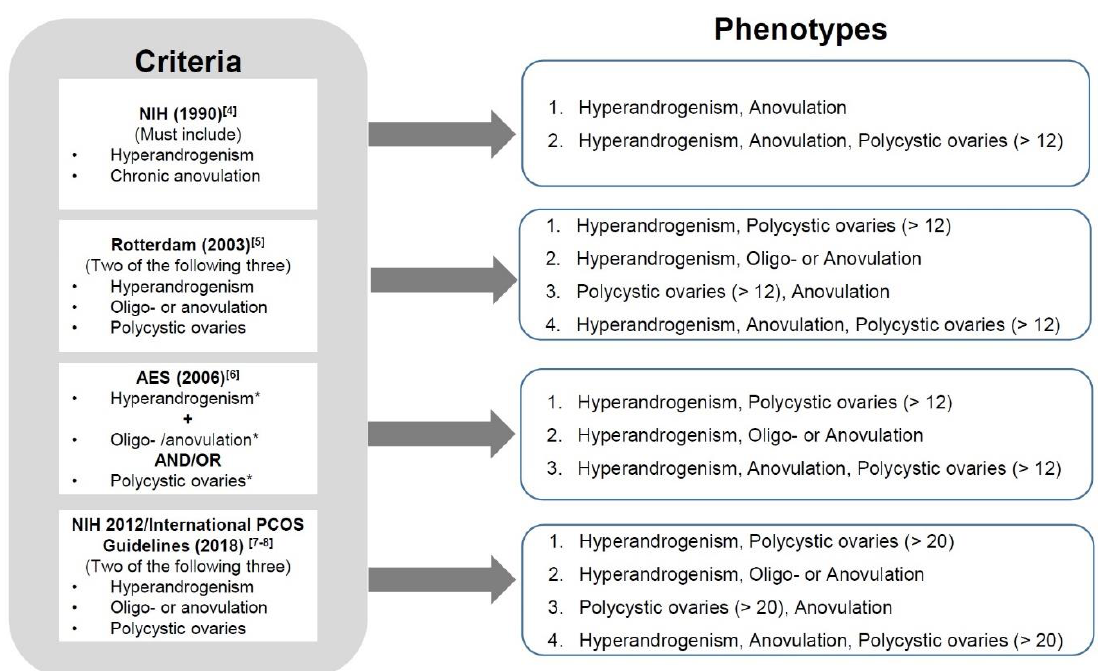
Figure 1. Diagnostic criteria and 4 main phenotypes of polycystic ovary syndrome (PCOS). *Hyperandrogenism: either testosterone above threshold and / or the presences of hirsutism or acne or androgenic alopecia. *Oligo-anovulation: eight or less ovulations per year. *Polycystic ovaries: ovarian volume > 10 mL and / or antral follicles number as defined above and less than 9 mm in size at least in one ovary.